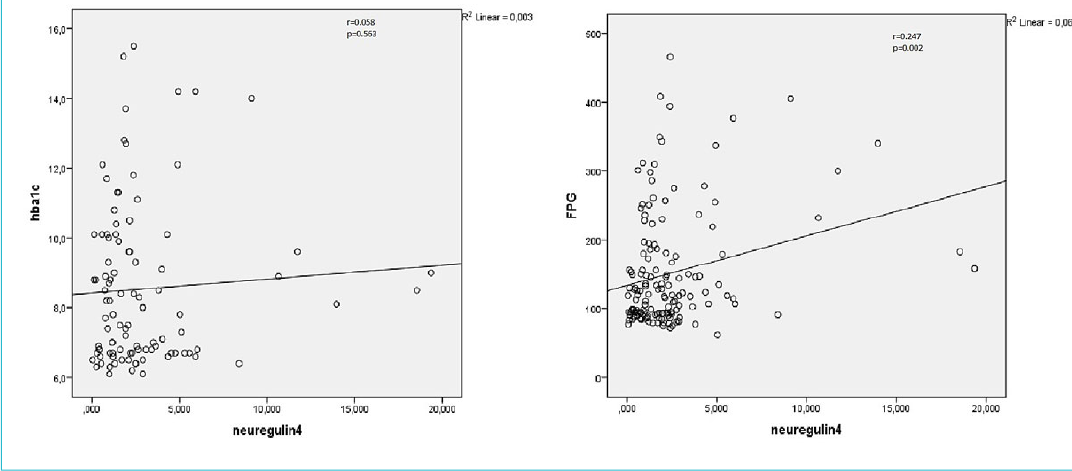
Figure 1: Correlation between neuregulin-4 and glycated haemoglobin (HbA1c) or fasting plasma glucose (FPG) levels.